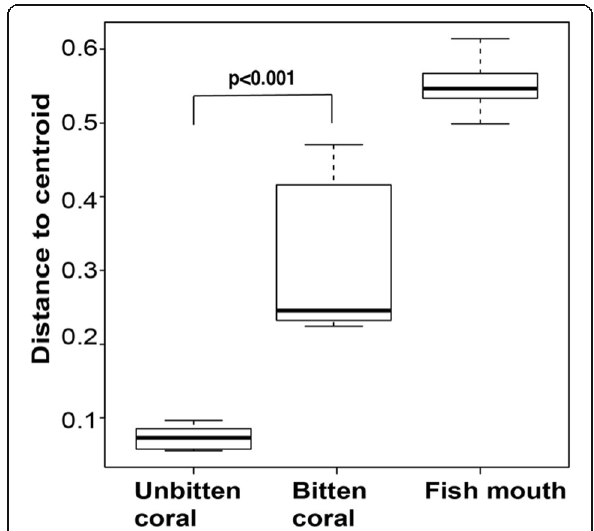
Fig. 5 Boxplots illustrating the level of community variability among sample types for the field experiment. P -values represent pairwise comparisons, using Tukey ’ s test, between unbitten and bitten